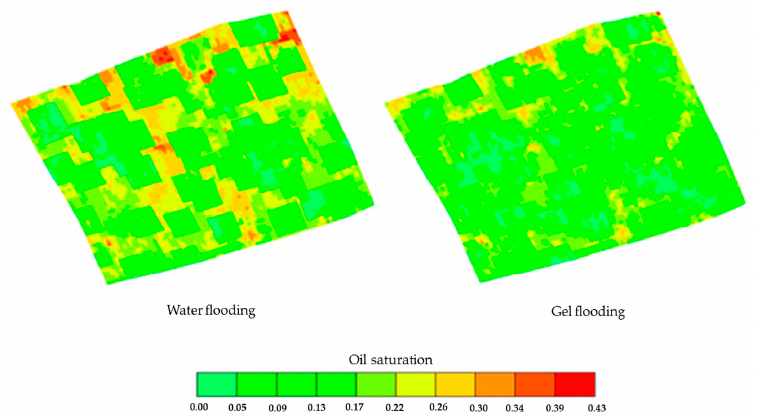
Figure 18. The remaining oil saturation distribution comparison between the optimal gel flooding scheme and water flooding.